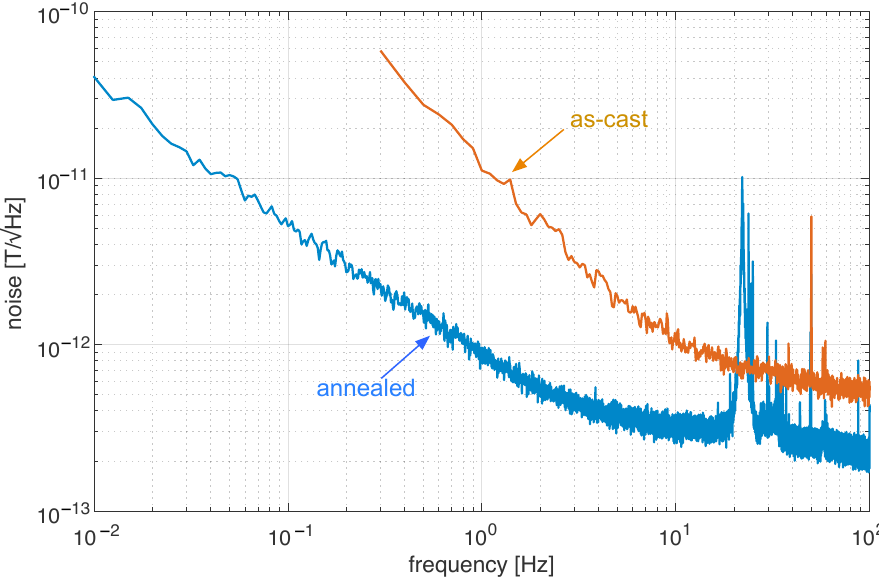
Figure 8. Noise spectra of a fluxgate magnetometer based on a wire with a nominal composition of ( Co ) 72.5 Si 12.5 B 15 produced by the the National Institute of Research and Development of 0.942 Fe 0.058 Technical Physics of Iasi, as-cast and after 5 min